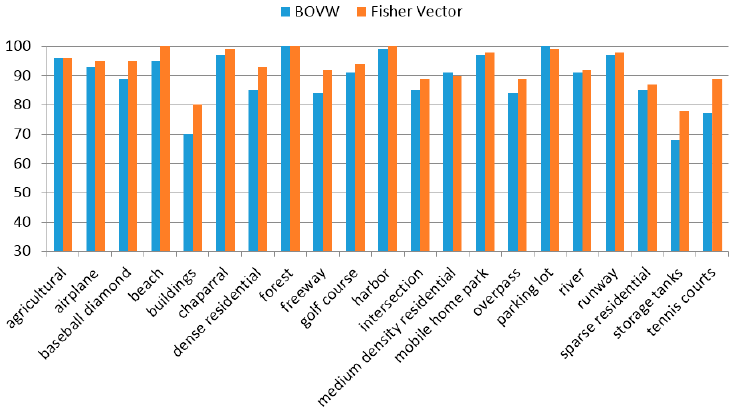
Figure 12. Per-class accuracy (%) of the proposed method and MS-CLBP+BOVW on the 21-class land-use dataset.